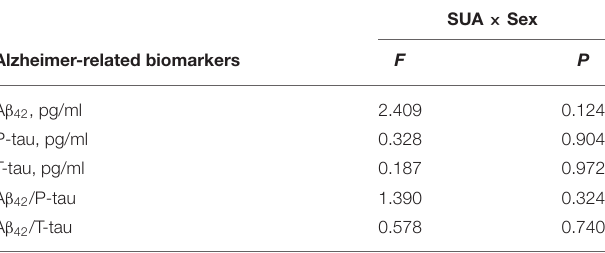
TABLE 4 | Transactional analysis in